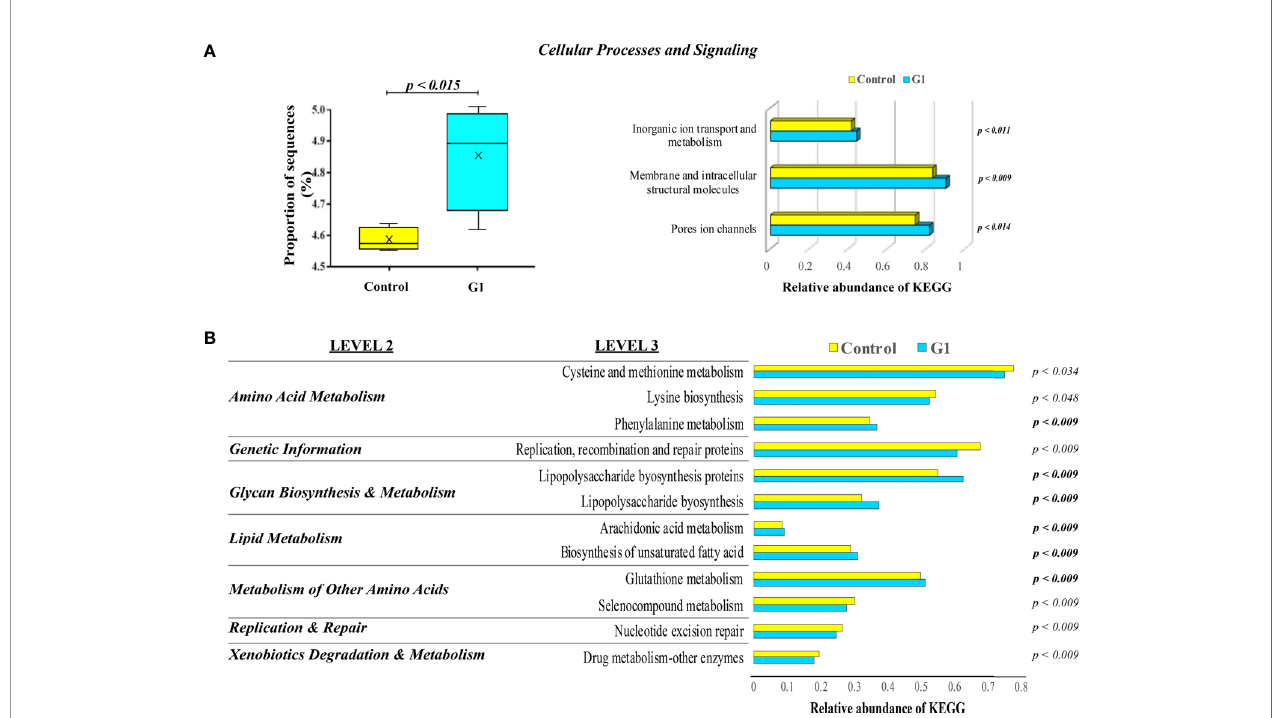
FIGURE 8 | KEGG pathways and functional annotation analysis of gut mucosa-associated microbiota compartments in unvaccinated seabream. (A) Box plots representing the signi fi cant proportion of the relevant abundance of PICRUSt generated functions pro fi le in the hindgut microbiota of gilthead seabream. The box represents the values between the 25 th and 75 th percentiles. The maximum and minimum values are represented by up and low caps. Treatment with the G1 containing diet led to a signi fi cant increase in the relative abundance of gene sequences in fl uencing critical cellular processes and signaling terms. (B) Signi fi cant Kyoto Encyclopedia of Genes and Genomes (KEEG) pathways level 2 and 3 enriched by predicted genomes of microbiota from control fi sh vs. G1-orally treated animals for 43 days. The signi fi cant overexpression of each KEGG term in G1 compared to control fi sh fractions are indicated by the resulting p-value in bold analyzed by ANOVA with a post-hoc Tukey-Kramer multiple comparison test